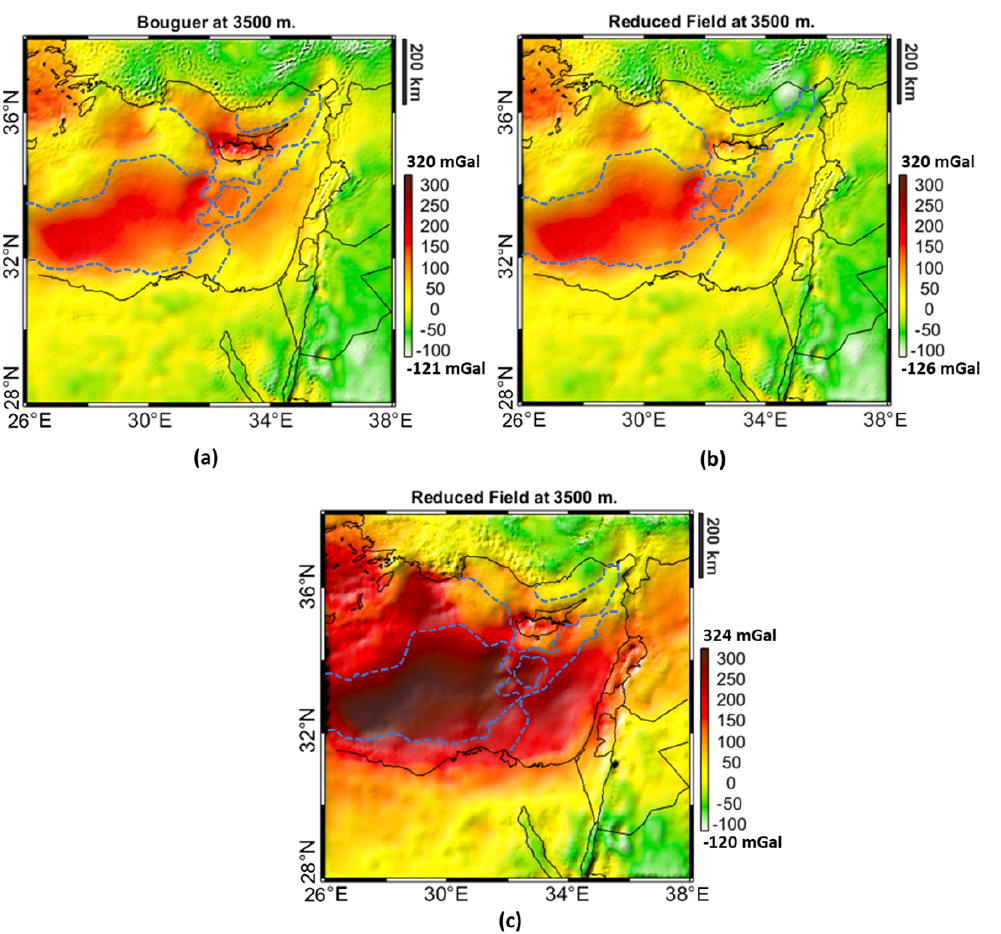
Figure 4. The Bouguer anomaly synthesized from the GECO global gravity model and reduced for ETOPO1 the topographic layer ( a ). The Bouguer anomaly corrected for the effect of the subduction plate beneath the Cyprus arc ( b ). The final reduced field once the effects of sediments and of the ophiolites have been removed ( c ). Dashed blue lines represent the boundary of the main geological